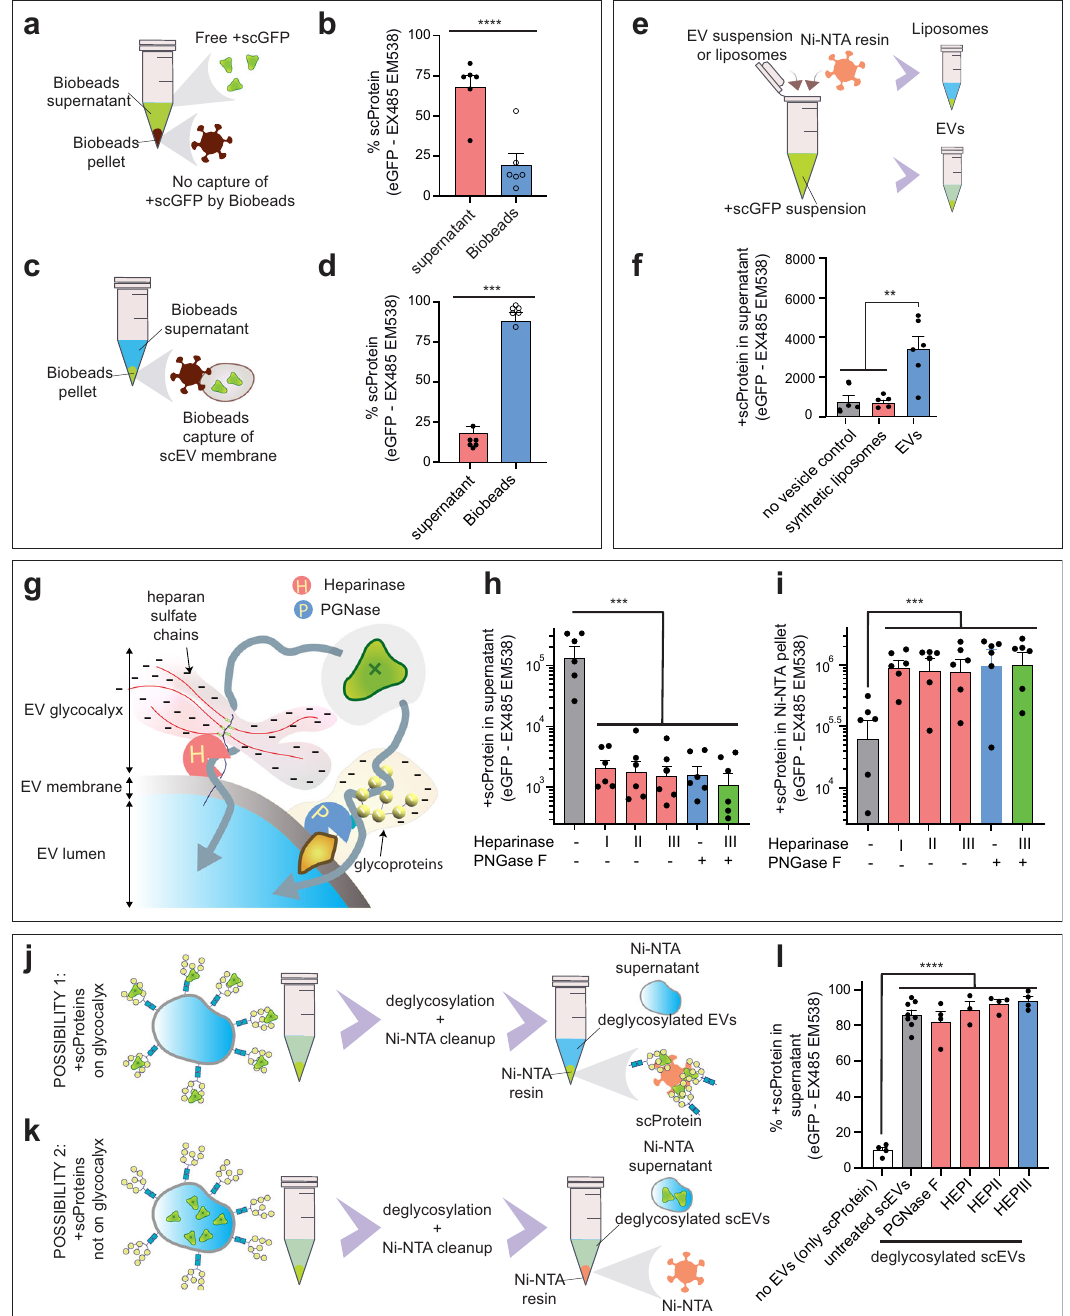
ceramide membrane dye 24 (Fig. 3a). To generate our Bodipy TR-scEVs, EV samples were incubated with dye prior to supercharging EVs (Fig. S4a). Our method included resolving a Bodipy TR labelled EV suspension over a SEC column removing free dye visible in the higher non-EV SEC fractions (Fig. S4b-I) and a 100 kDa/~10 nm cut-off fi lter treatment to clean up any potential free + scProtein remaining in our suspension. Free + scProtein was demonstrated to pass through a 100 kDa cut-off fi lter but could be retained by a 30 kDa/~3 nm cut-off fi lter (Fig. S4b-II). Of note, non-supercharged Bodipy TR-EV controls were generated from the same EV source sample as our Bodipy TR-scEVs avoiding batch-to-batch variations between EV production (Fig. S4a). In our fi nal suspension, the BODIPY COMMUNICATIONS BIOLOGY| (2022) 5:485